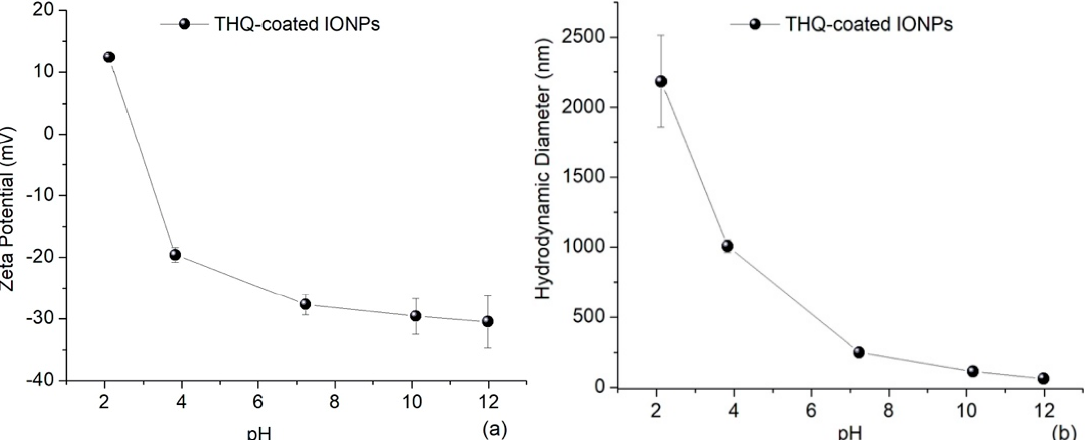
Figure 4. Measurements of the zeta potential ( a ) and the hydrodynamic diameter ( b ) of the THQ-coated IONPs in the pH interval from 2.1 to 12.